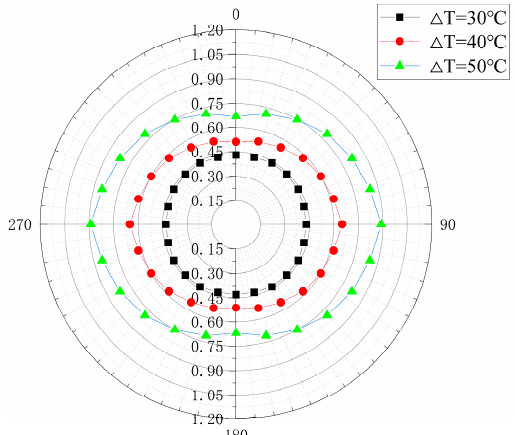
Figure 7. Annular distribution of frost heave force of rock mass with different temperature differences.